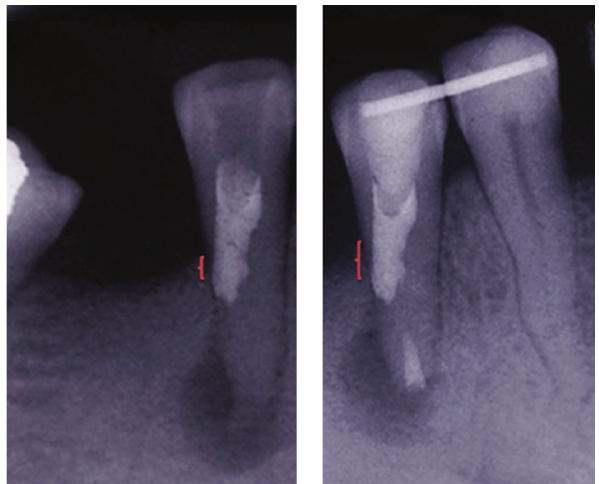
Figure 7: The distance between perforation site and the alveolar crest that has been shown with the red brackets was increased after root resection and tooth